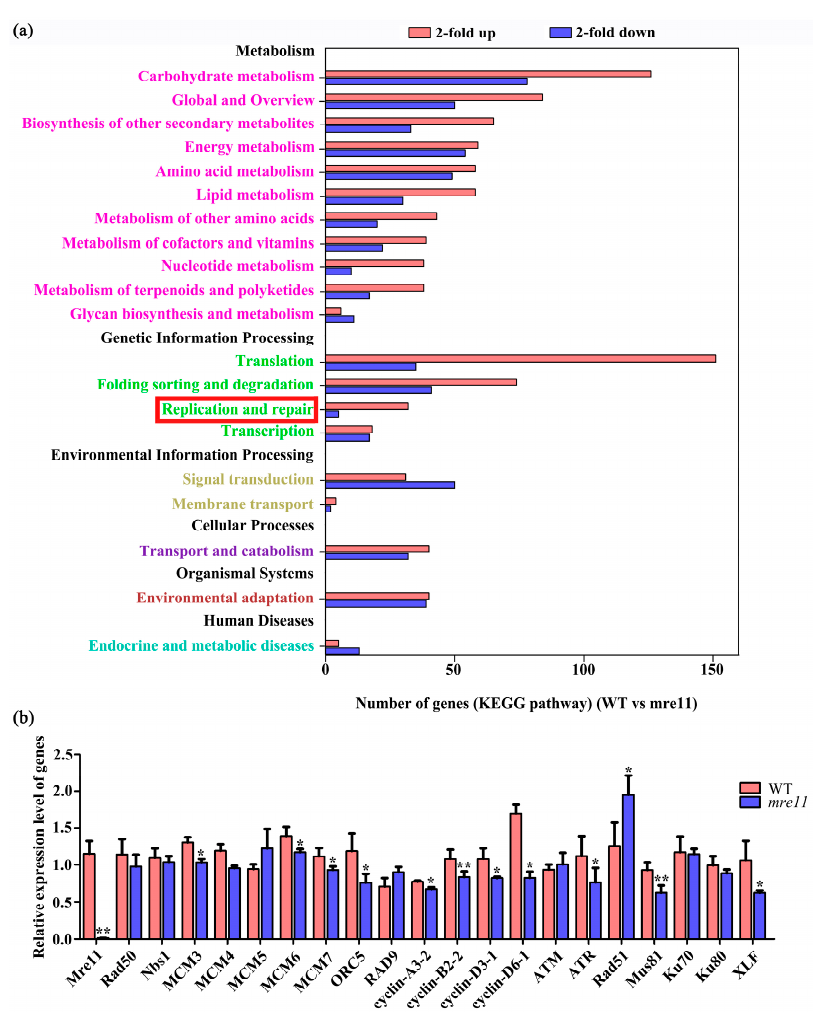
Figure 9. RNA sequencing analysis and verification of gene expression in rice WT and the mre11 seedlings. ( a ) The number of 2-fold up and down-regulated genes in the Kyoto Encyclopedia of Genes and Genomes (KEGG) pathway (WT vs. mre11 ). Many genes related to replication and repair had changed significantly in the mre11 compared with WT (in the red frame). ( b ) The relative expression level of genes related to DNA replication, cell cycle, and DNA repair in WT and the mre11 seedlings. The asterisks represent a statistically significant difference according to Student’s t-test (*, 0.01< p <0.05; **, p < 0.01).